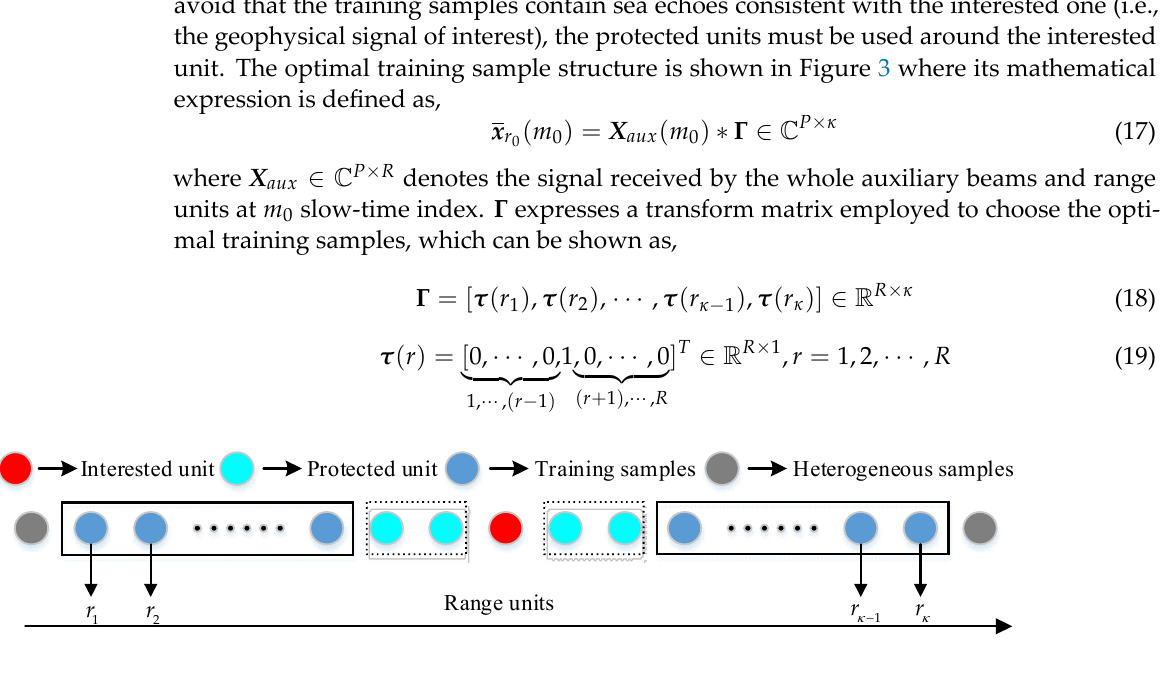
Figure 2. The ADLR structure.